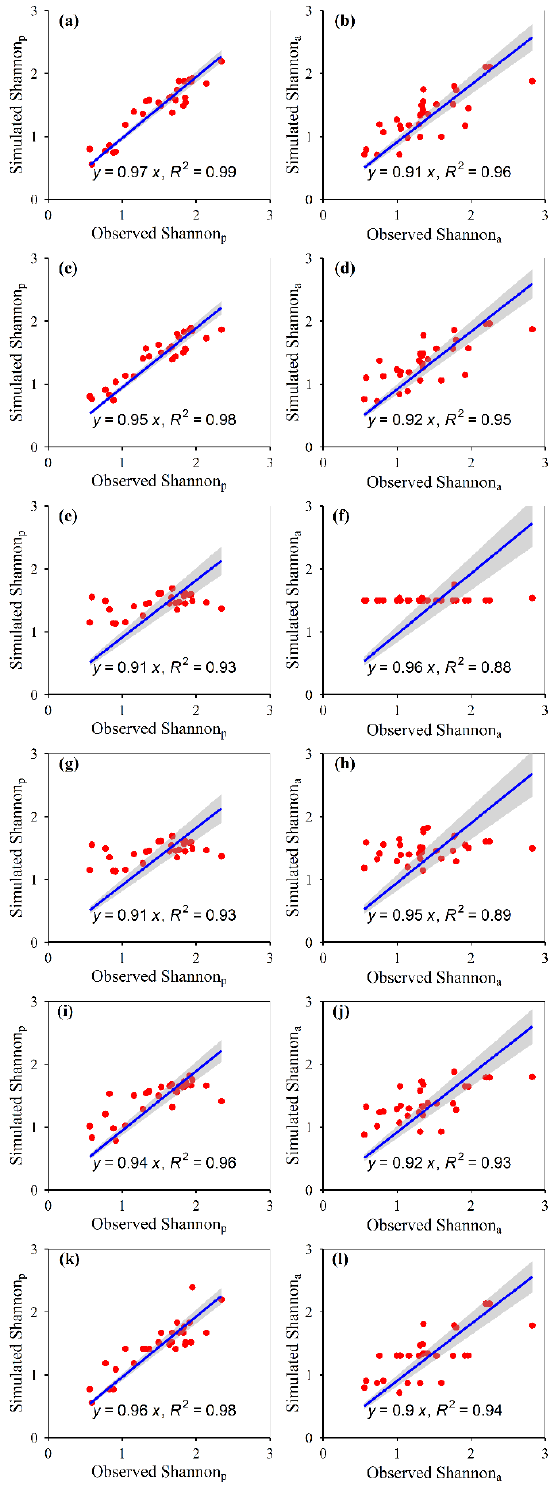
Figure 3. Correlations between the simulated and observed Shannon of the plant community under fencing ( a , c , e , g , i , k ) and grazing ( b , d , f , h , j , l ) scenes, for random forest ( a , b ), generalized boosted re- gression ( c , d ), artificial neural network ( e , f ), multiple linear regression ( g , h ), support vector machines ( i , j ) and recursive regression trees ( k , l ). The solid lines indicate the linear fitted lines between the simulated and observed Shannon. Shannon p : potential Shannon; Shannon a : actual Shannon. All the regressions were significant at p <